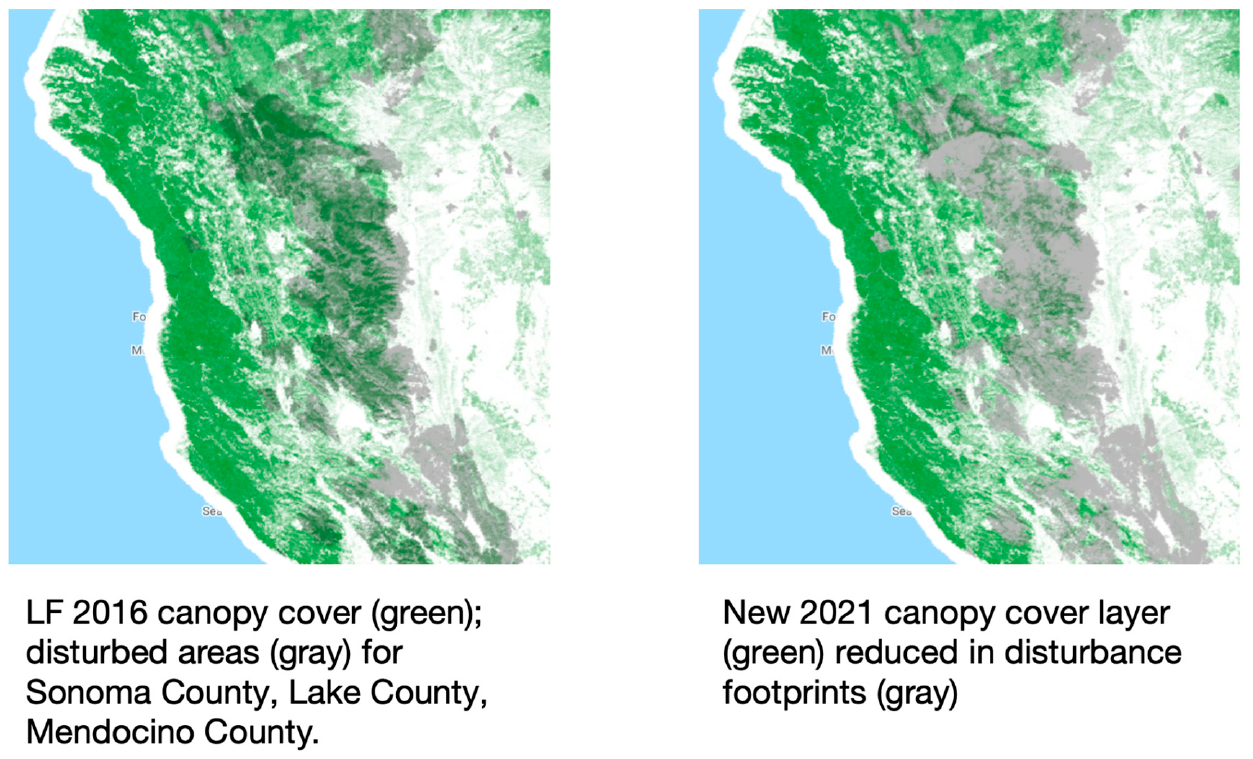
Figure 3. Modified surface fuel estimates: (left) LANDFIRE 2016 canopy cover (green) and identified disturbances 2017–2020 (gray) are shown. (Right) new canopy cover estimates (green) are reduced in disturbed areas.